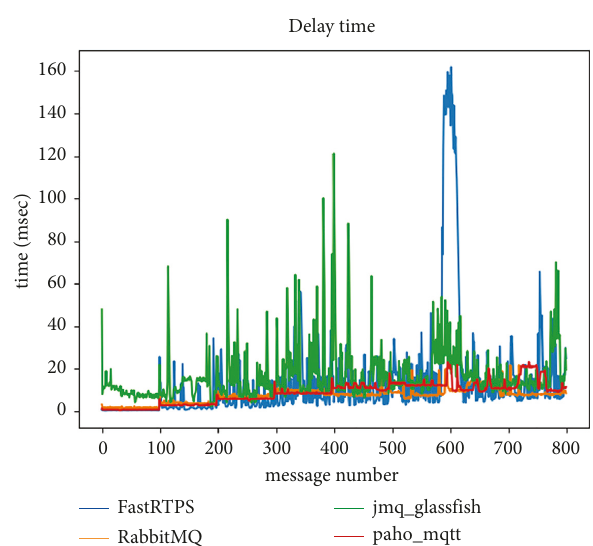
Figure 9: Delay of messages with 100 msgs/sec frequency.